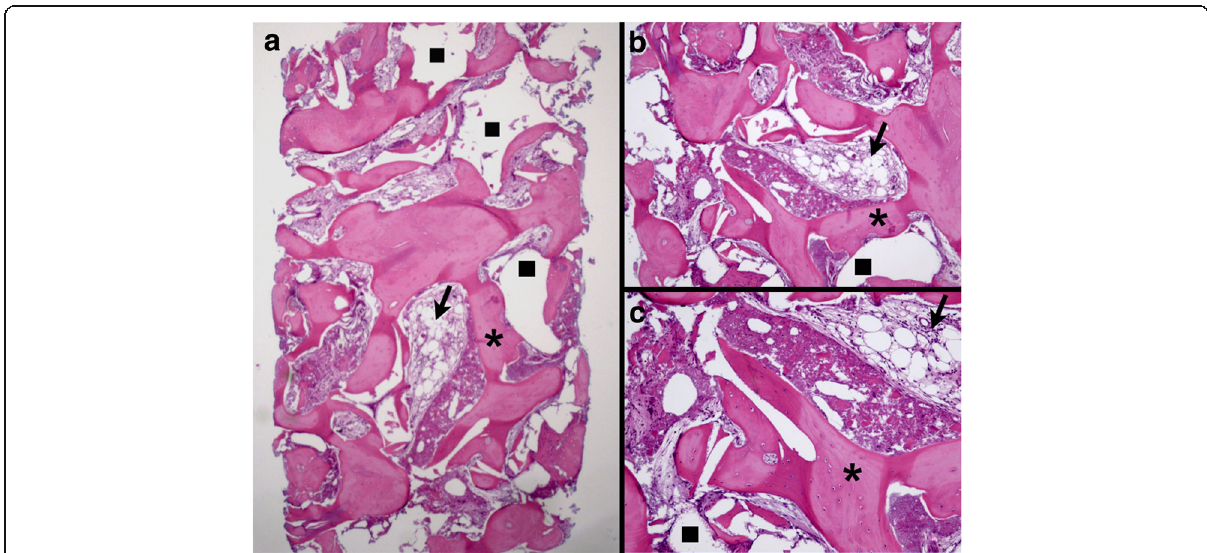
Fig. 2 Histomicrograph of a biopsy from the BC group. a Overview — ×25 magnification; b ×30 magnification; c ×60 magnification. Areas corresponding to BC removed during histological processing ( square ) in direct contact with newly formed bone ( asterisk ), containing a large number of osteocytes, and with soft tissue ( arrow ) can be observed (hematoxylin-eosin stain)